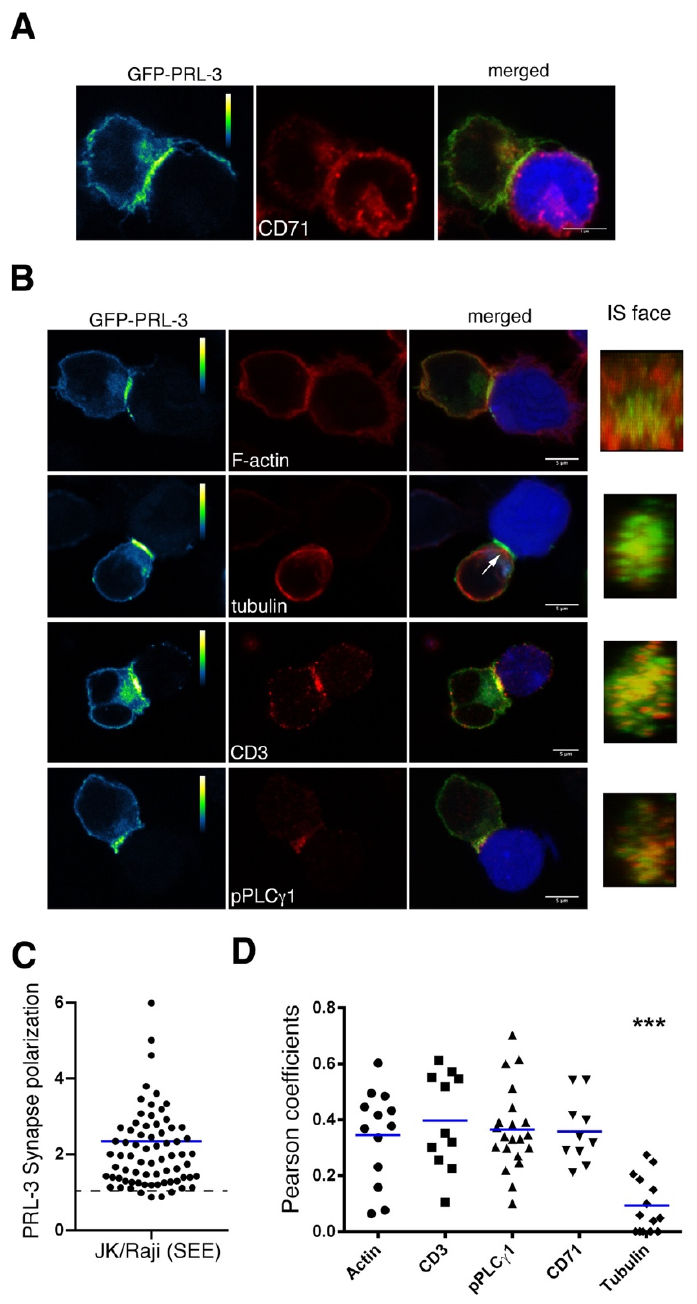
Figure 2. Distribution of GFP-PRL-3 to the immunological synapse. ( A and B ) Representative cell conjugates of JK cells interacting with SEE-loaded and CMAC (blue) labelled Raji cells. The green (pseudocolor) and red channels as well as the merged images are shown. The molecule stained and observed in the red channel is indicated. Calibration bar of the pseudocolor is indicated. Scale bar: 5 μ m. The IS face obtained from the 3D reconstructions is shown. A white arrow points to the MTOC polarized to the IS. ( C ) Synapse polarization of GFP-PRL-3 assessed from the increment in fluorescence at the IS in comparison with the rest of the cell. Dots indicate individual cells analyzed and the blue line the average value. The dashed line indicates the ratio equals 1, meaning no polarization. ( D ) Pearson coefficients for assessing the colocalization of GFP-PRL-3 with the indicated molecule at the IS. Symbols indicate the analyzed cells and blue lines average values. Samples were compared by an ordinary one-way ANOVA with a Tukey’s multiple comparison test. Samples stained for tubulin were statistically different. *** p < 0.001.